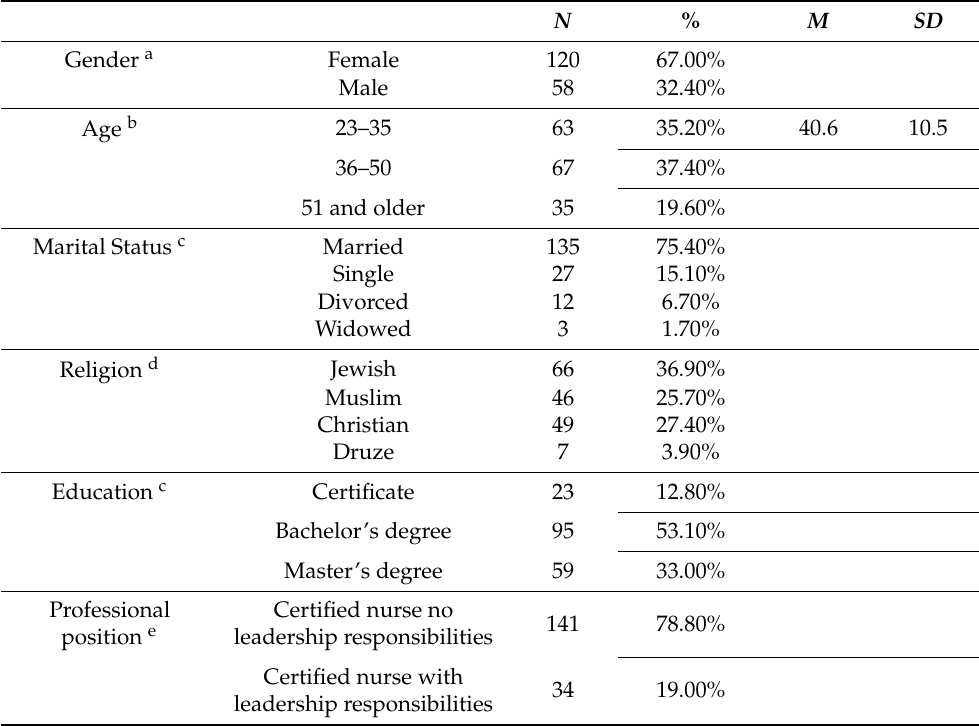
Table 1. Sample Demographic and Professional Characteristics ( N =